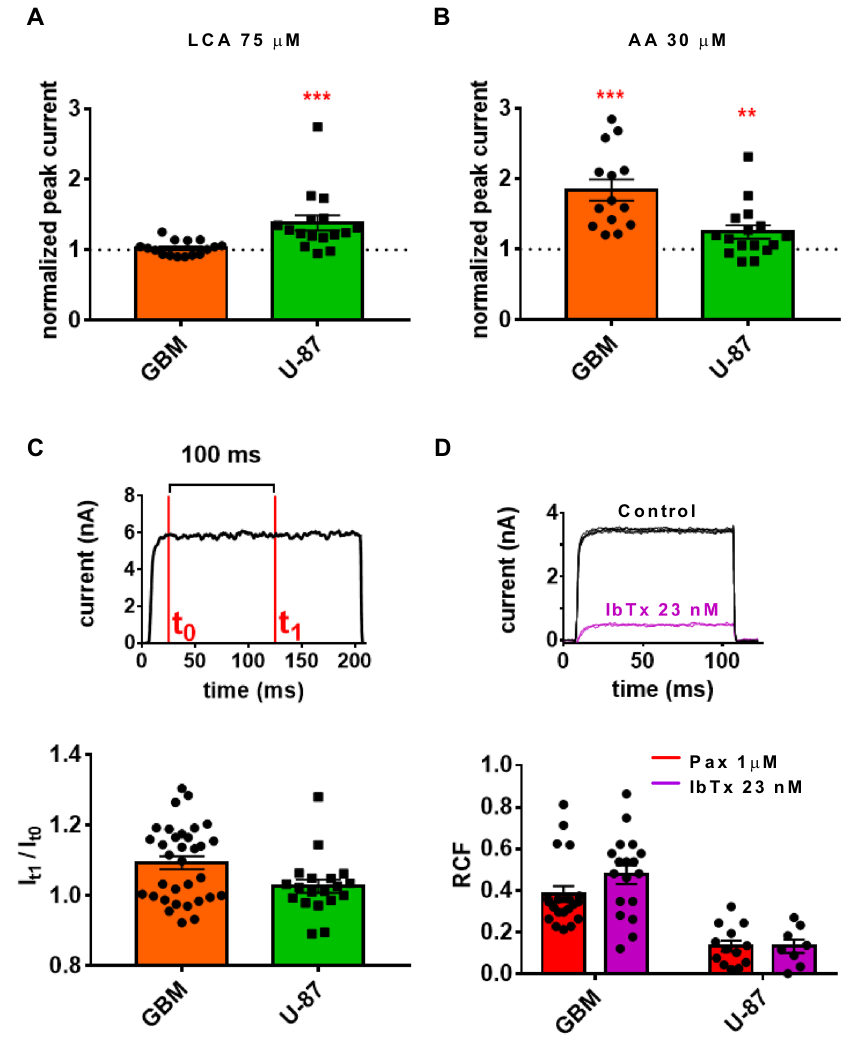
Figure 2. Pharmacological modulators affect β subunit-associated K Ca 1.1 channels in glioblastoma. ( A ) The effect of lithocholic acid (LCA, 75 µM) on primary GBM (orange bar, n = 16) and U-87 MG cells (green bar, n = 16). The current recorded during LCA application was normalized to the current recorded in control solution (dotted line). ( B ) The effect of arachidonic acid (AA, 30 µM) on primary GBM (orange bar, n = 14) and U-87 MG (green bar n = 16) cells. The current recorded during AA application was normalized to the current recorded in control solution (dotted line). ( C ) Channel inactivation in a 100 ms time interval was determined by the current ratio I t1 /I t0 , where t 0 was the current amplitude at the beginning, and t 1 was the current amplitude at the end of the 100 ms time interval for primary GBM cells (orange bar, n = 33) and for U-87 cells (green bar, n = 19). The pipette filling solution contained 1 µM Ca 2+ concentration. ( D ) The effect of iberiotoxin (IbTx, 23 nM, purple bars, for GBM n = 18, for U-87 n = 8) and paxilline (Pax, 1 µM, red bars, for GBM n = 20, for U-87 n = 13) on the K Ca 1.1 current in primary GBM and in U-87 cells. Black symbols indicate remaining current fraction (RCF) values obtained in individual cells. RCF is defined in the text and in the legend of Fig. 1. Currents in panels C and D were evoked by depolarizations to + 100 mV, the pipette filling solution contained 1 µM Ca 2+ concentration. Data in the bar graphs represent mean ± SEM, ** p < 0.01, *** p <